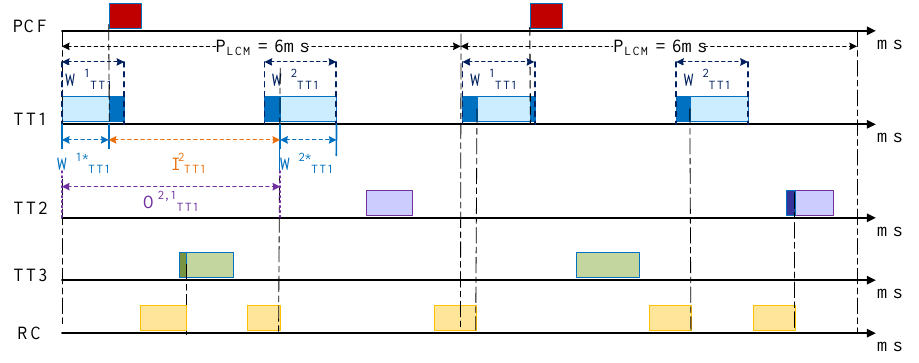
Figure 6. Acceptance windows for